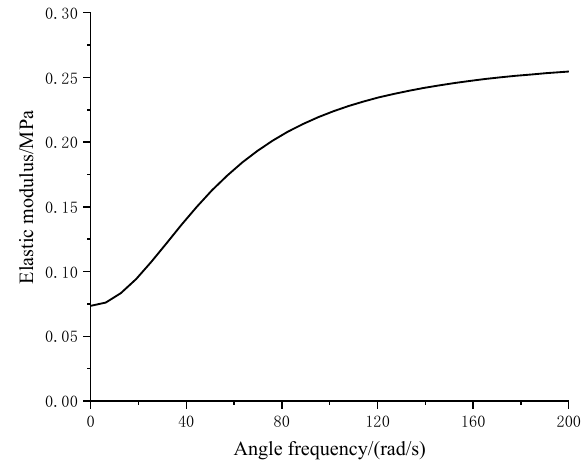
Figure 12. Elastic modulus varies with frequency.